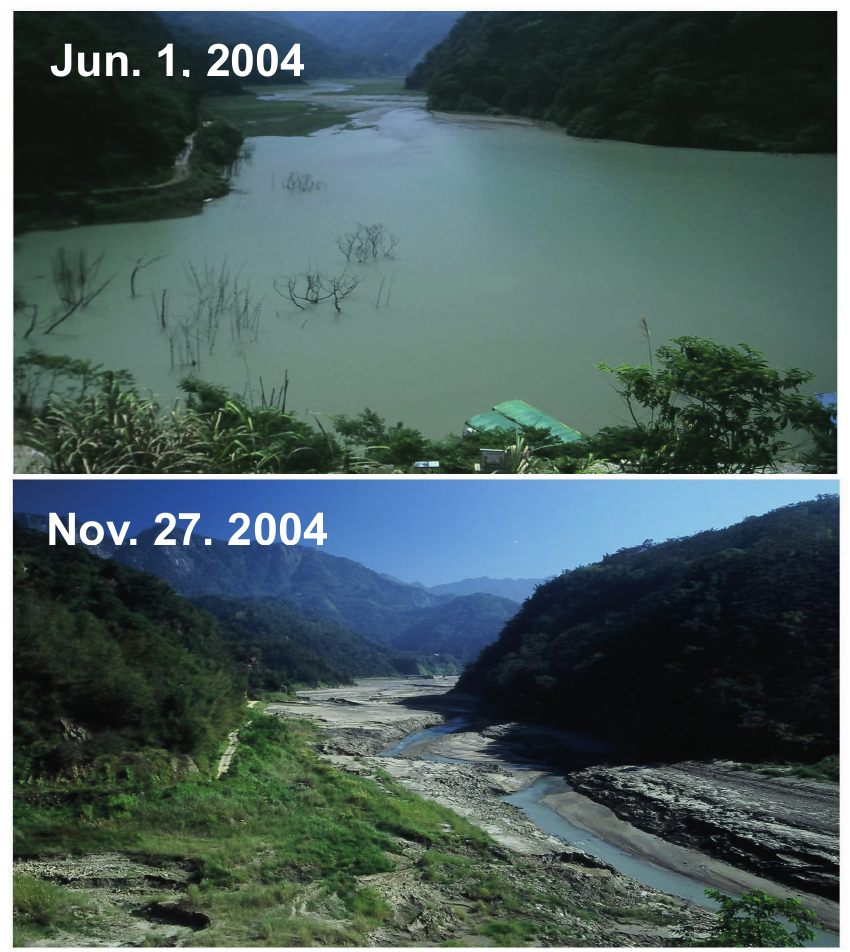
Fig. 3 Tsaoling landslide lake before (1 June 2004) and after (20 July 2004) its breaching and subsequent draining. Breaching occurred early on 2nd June, coincident with the marked increase in Chingshui water discharge and dissolved NO 3 levels (see Fig.